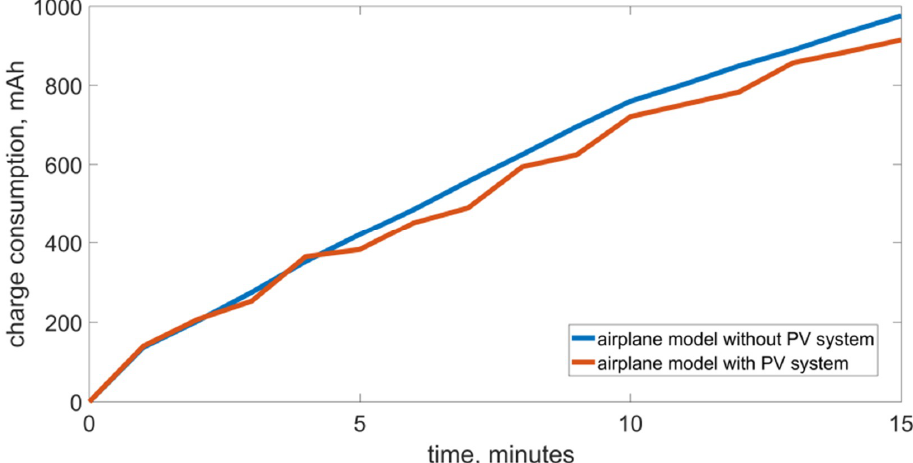
Figure 5. Charge consumption from the battery during the flight time for the model plane (UAV) without a PV system and with the plane model (UAV) with a PV system where battery consumption is partially compensated for with the PV source (measurement insecurity is 1%).